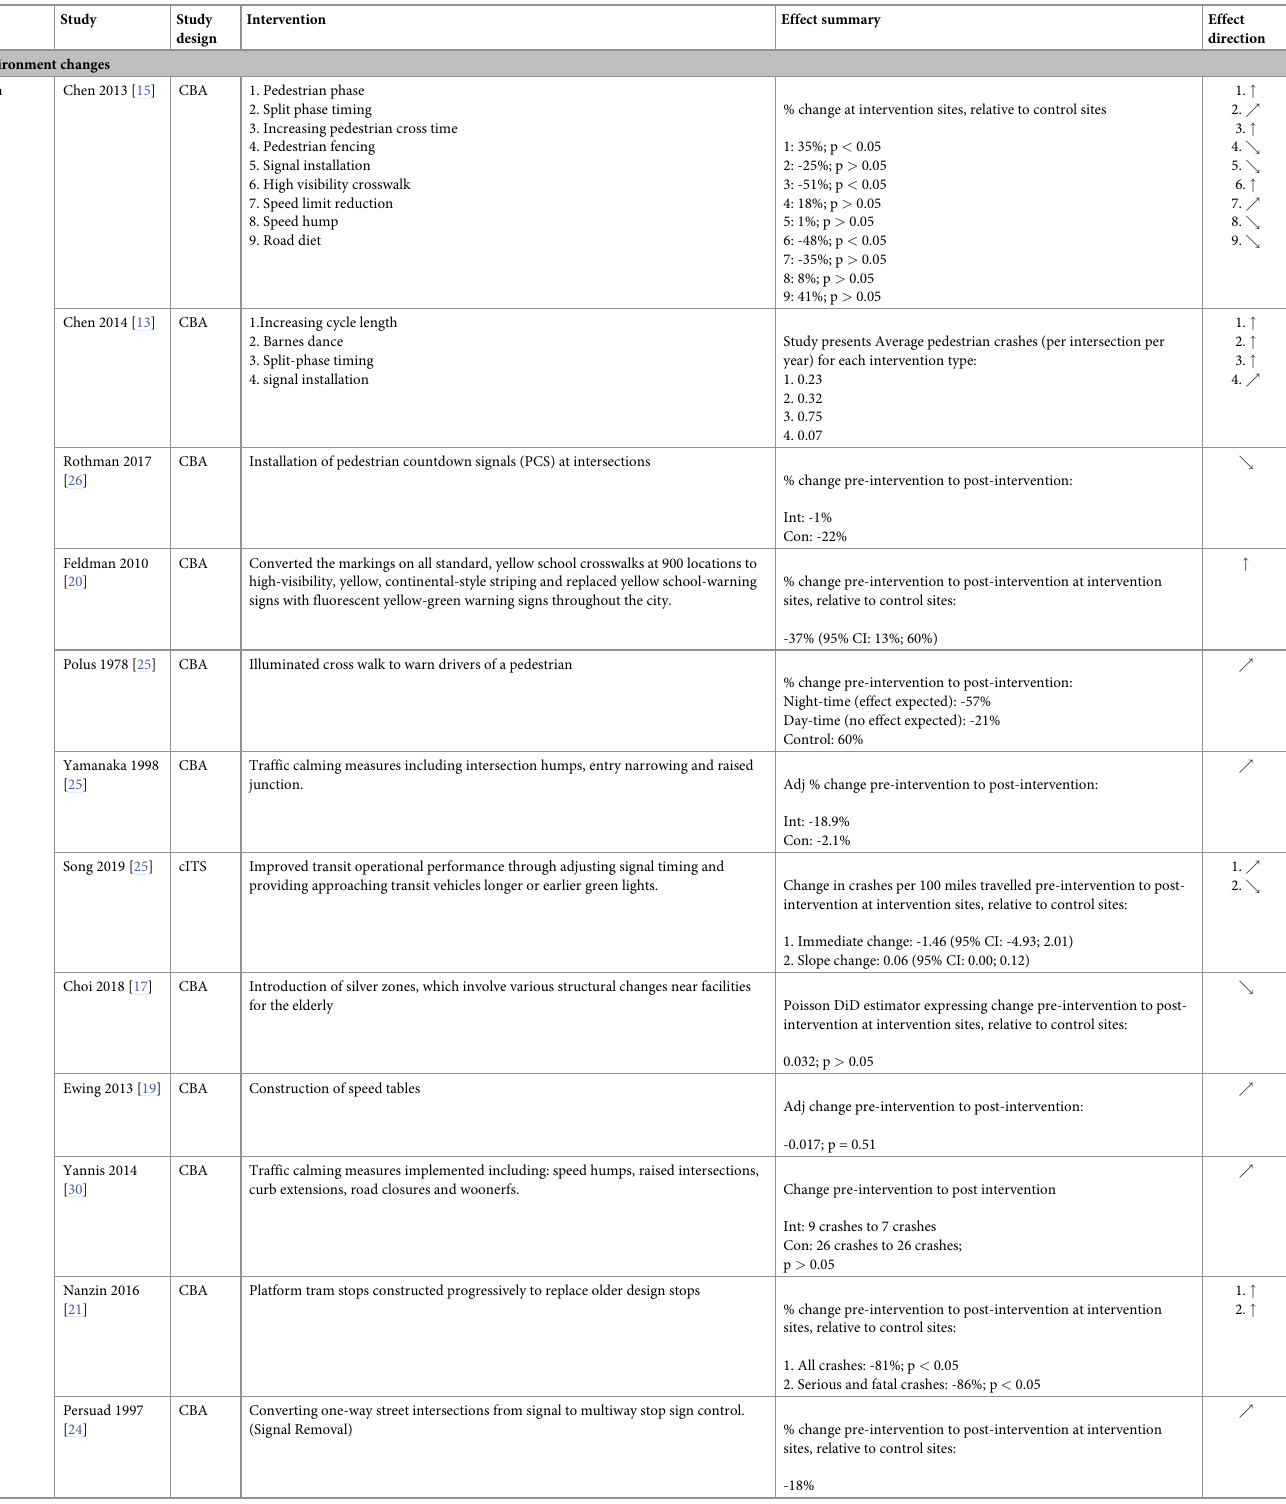
Table 4. Data from included studies underlying the summary of effect direction.